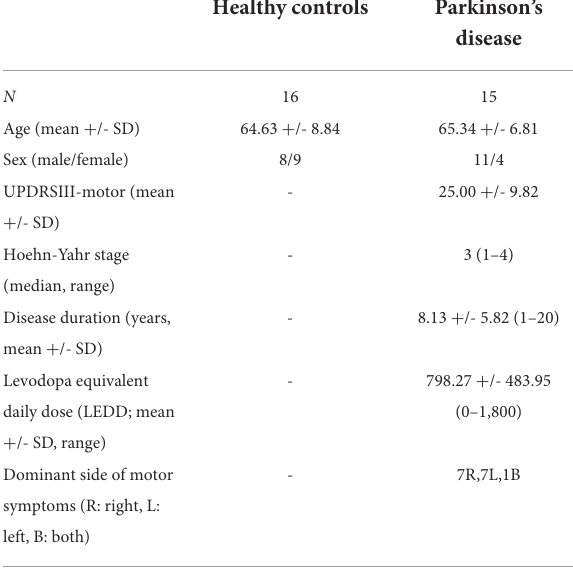
TABLE 1 Demographic data of the